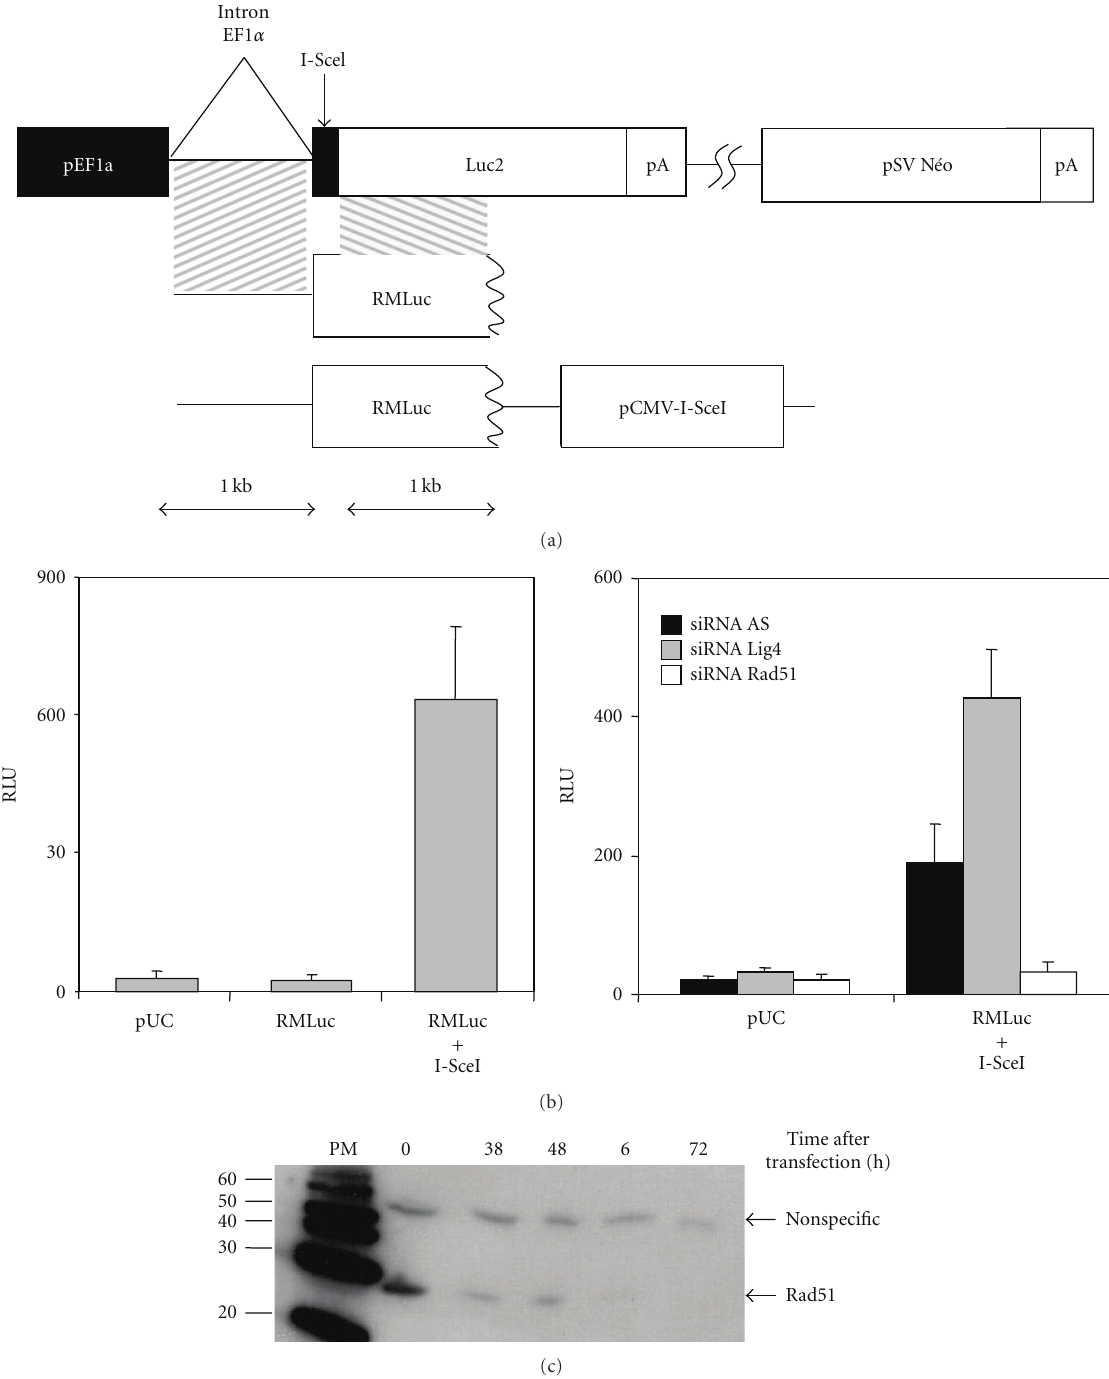
Figure 1: A cell-based assay for identifying factors stimulating I-SceI-induced HGT. (a) A reporter system for I-SceI-induced gene targeting. The firefly luciferase gene (Luc2) is inactive due to replacement of the first 22 base pairs (bp) by a 24 bp I-SceI site (vertical black box). The plasmids constructed for I-SceI-induced gene targeting are described as follows: RMLuc+I-SceI has (i) the first 22 bp of the luciferase gene surrounded by 1kb of homologous sequence (hatched boxes); (ii) an I-SceI induction cassette under the control of a CMV promotor. The RMLuc plasmid does not contain the I-SceI expression cassette. (b) Validation of the cell-based assay. The E2 cell line carrying a single integrated copy of the reporter system described in (a) was transfected with empty vector (pUC), RMLuc, or RMLuc+I-SceI (left panel). Luciferase activity was analyzed 72 hours after transfection. The E2 cell line was also cotransfected with either pUC or with RMLuc+I-SceI plus siRNAs known to modulate gene targeting (right panel): RAD51 siRNA and LIG4 siRNA. The results obtained were compared with those for cotransfection with the control All Star (AS) siRNA. Luciferase activity was assessed 72 hours after transfection. (c) Western blot analysis of Rad51 protein levels at various times after transfection, for the E2 clone with RMLuc+I-SceI and RAD51 siRNA. Specific and nonspecific bands were detected at 30 and 50kDa,